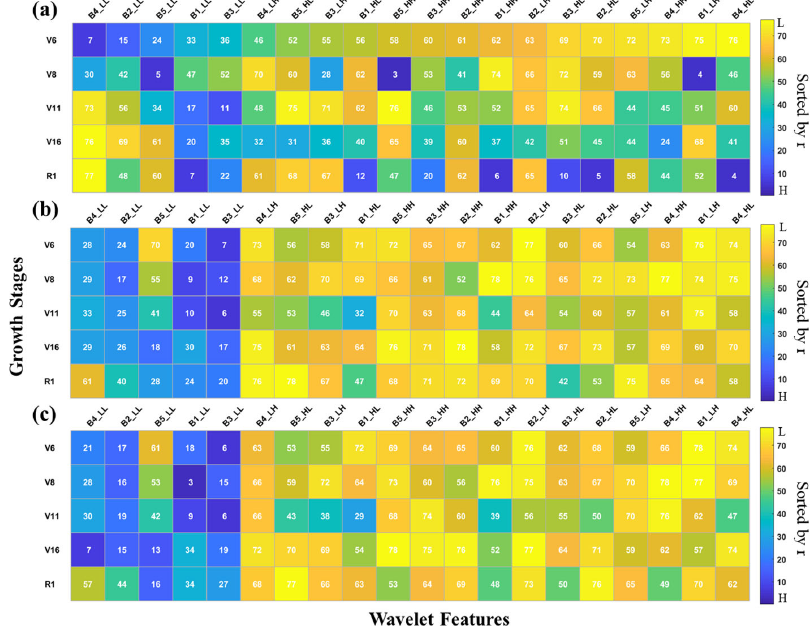
Figure 9. The ranking of the correlation between wavelet features and the target variables. ( a ) The ranking of the correlation between wavelet features and LCD. ( b ) The ranking of the correlation between wavelet features and LAI. ( c ) The ranking of the correlation between wavelet features and CCD. Note: The abscissa feature order of ( a – c ) is the descending order of the correlation between features and LCD at the V6 growth stage. The numerical value in the color bar represents the serial number of each feature. The smaller the serial number, the greater the r. For example, the number 1 represents the largest value of the r. H represents the high correlation; and L represents the low correlation. B1 represents the reflectivity of the first band of the multispectral image, and other